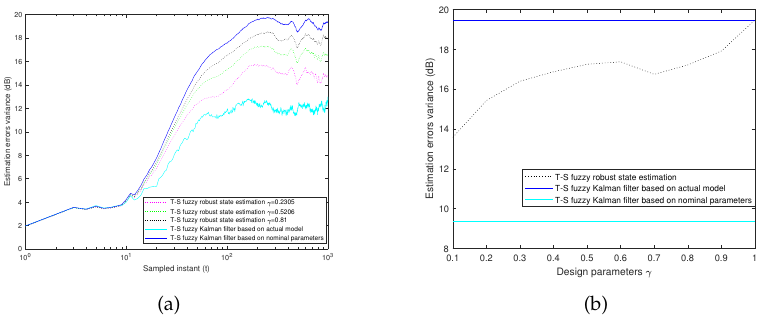
Figure 3. The model error, ε t , is not fixed. ( a ) The design parameter, γ , is fixed. ( b ) The sampled instant, t , is